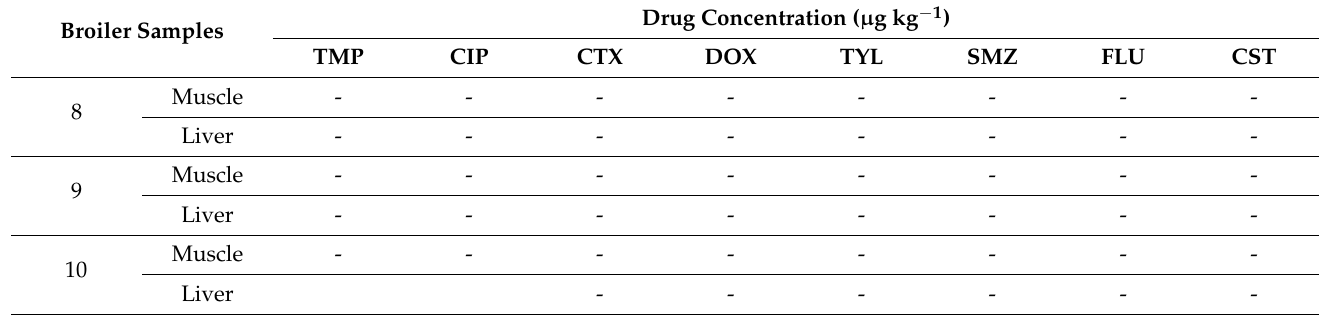
Figure S2: Response surfaces related to the interaction effects of the percentage of acetonitrile and column temperature: (a) retention time of (TMP) peak, (b) retention time of (CST) peak, (c) resolution (TMP-CIP) peaks, (d) resolution (CIP-CTX), (e) resolution (CTX-DOX) peaks, and (f) resolution (DOX-TYL) peaks; Figure S3: Response surfaces related to the interaction effects of the percentage of acetonitrile and mobile phase flow rate: (a) retention time of (TMP) peak, (b) retention time of (CST) peak, (c) resolution of (TMP-CIP) peaks, (d) resolution of (CIP-CTX) peaks, (e) resolution of peaks (CTX-DOX) peaks, and (f) resolution of (DOX-TYL) peaks. The column temperature was kept constant at 30 ◦ C; Figure S4: Response surfaces related to the interaction effects of the column tem- perature and mobile phase flow rate: (a) retention time of (TMP) peak, (b) retention time (CST) peak, (c) resolution of (TMP-CIP) peaks, (d) resolution of (CIP-CTX) peaks, (e) resolution of (CTX-DOX) peaks and (f) resolution (DOX-TYL) peaks. The percentage of acetonitrile was kept constant at 10%; Figure S5: Response surface obtained for the desirability function for different two factors interaction for optimization of HPLC-UV method; Table S1: (a) Factors examined in the screening phase for factors affecting extraction procedure FFD, (b) Design matrix. (c) The corresponding extraction procedure. (a) Design matrix, (b) the corresponding experimental response values; Table S3: (a) Factors examined in the screening phase of HPLC-UV separation conditions (FFD), (b) design matrix, (c) the corresponding experimental response values for factorial design; Table S4: CCD for HPLC response optimization. (a) Design matrix and (b) the corresponding experimental response values; Table S5: ANOVA results for FFD for screening of the factors affecting the extraction proce- dure. A 5% level of significance was desired; Table S6: ANOVA results for CCD for optimization